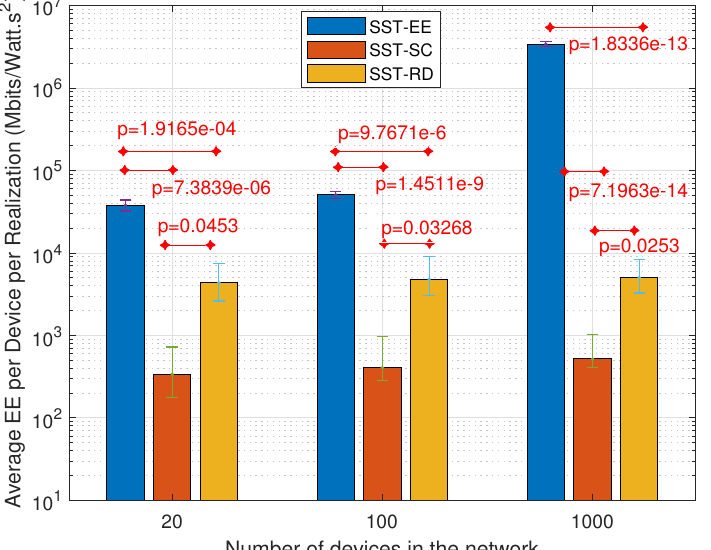
Figure 13. Variation in the average energy efficiency per device per realization considering the